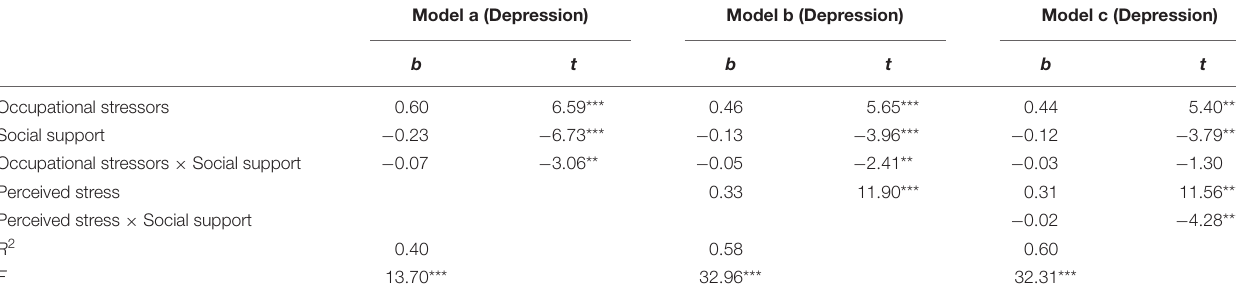
TABLE 5 | Testing the moderated mediation effect in the model of depression.